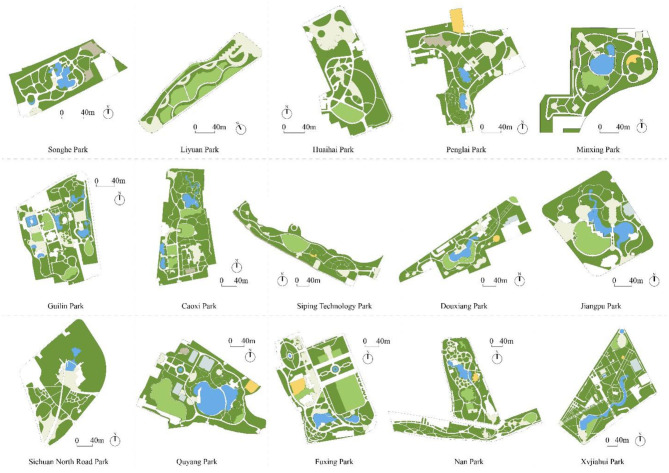
Master Plans of the 15 neighborhood parks. [Figure credit: authors; an adapted version of figure has been published in article that belong to the same project (13).]